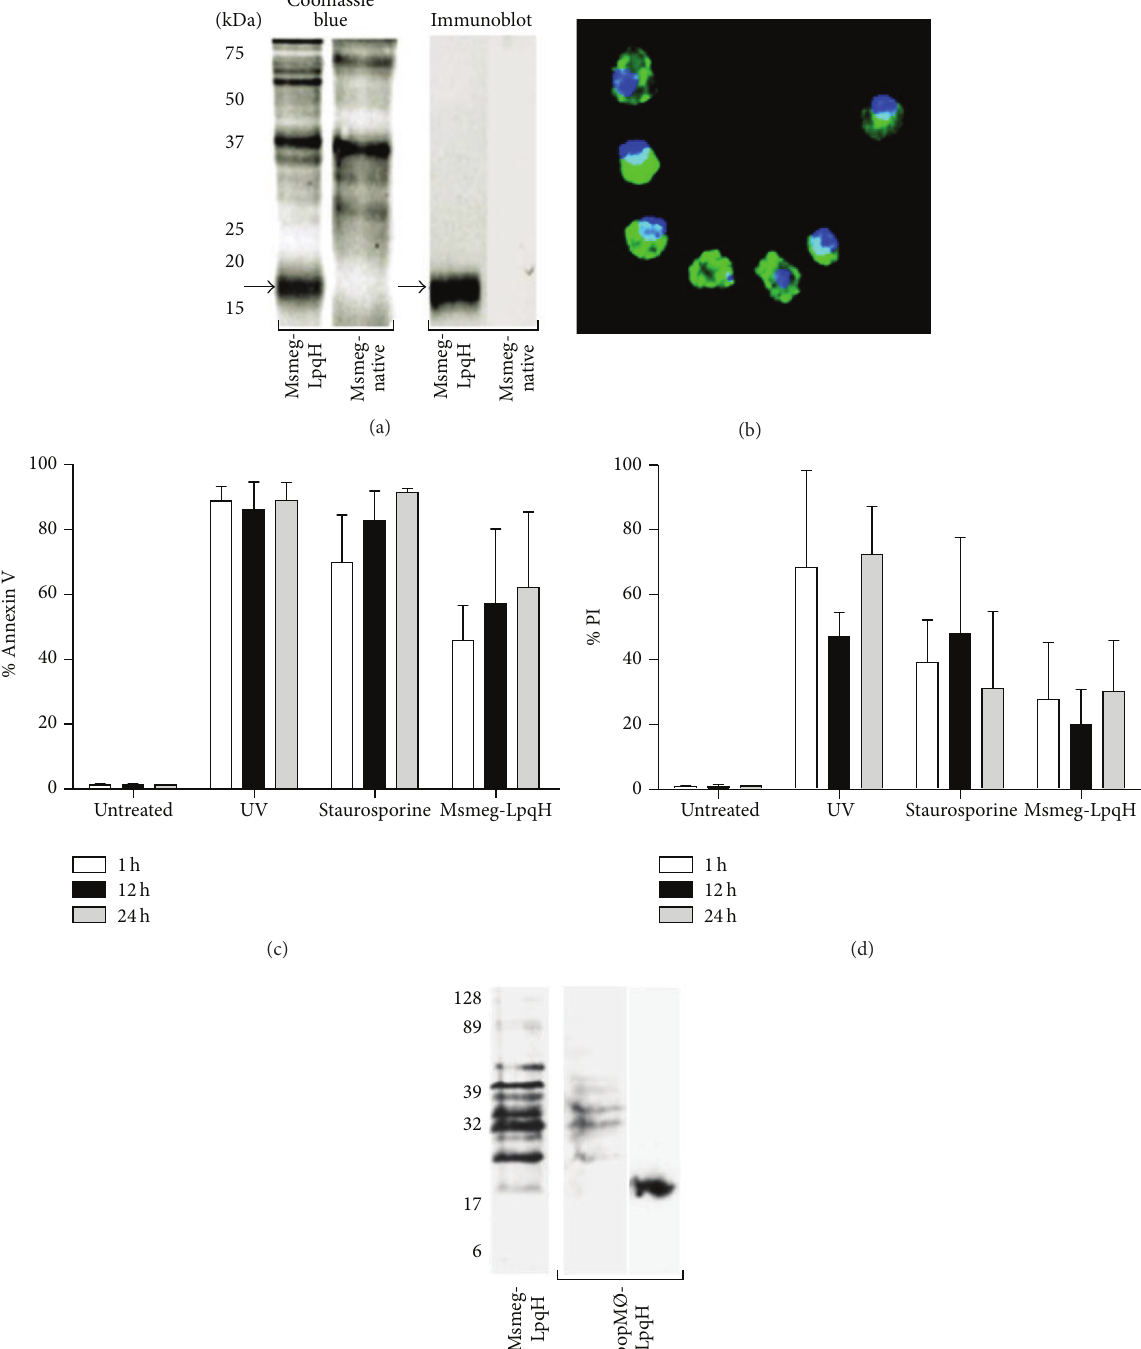
Figure 1: Mycobacterial cell walls mediate the apoptosis of bone marrow macrophages. Demonstration of mycobacterial proteins in apoptotic cells. The cell wall of the transformed M. smegmatis strain (Msmeg-LpqH)expresses LpqH, the19-kDa Mtb glycolipoprotein ((a), arrows). The native strain does not express the protein. Bone marrow MØs treated with mycobacterial cells that carry LpqH develop apoptosis, as verified by epifluorescence ((b), original 40x) and flow cytometry with FITC-labeled Annexin V (c). With staurosporine and UV, higher levels of apoptosis were observed (c). High level necrosis as revealed with propidium iodide was observed (d). Immunoblotting of mycobacteria- induced apoptotic MØs (ApopMØ-LpqH) with an anti -M. smegmatis antiserum and with a mAb revealed the presence of a few M. smegmatis antigenic bands (left) and LpqH (right). Msmeg-LpqH, protein profile of the M. smegmatis cell wall used to induce apoptosis (e). UV, ultraviolet light. We show representative results of three independent